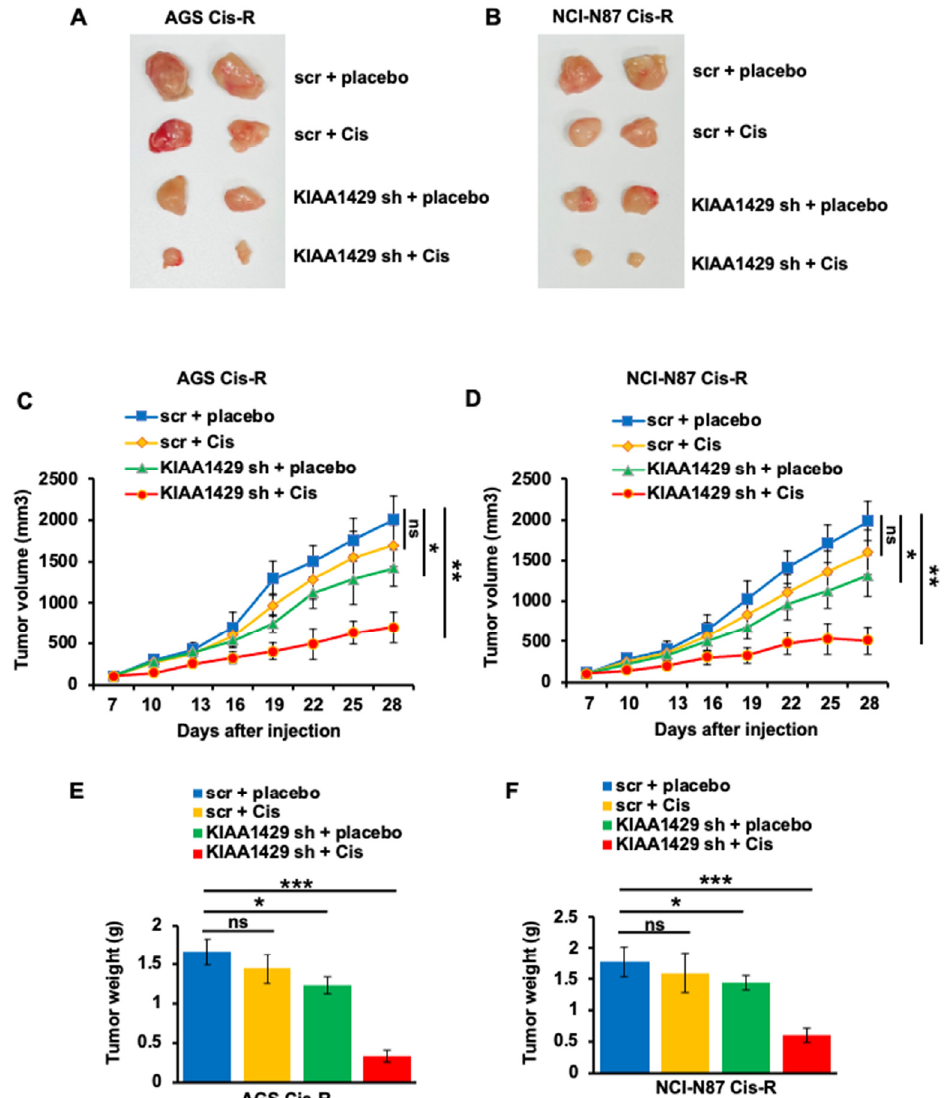
Figure 6. Effect of KIAA1429 depletion on cisplatin resistance in vivo. ( A , B ) Typical photos of tumors from each group. ( C , D ) Tumor growth curve indicated that KIAA1429 depletion significantly rescued the response of AGS Cis-R ( C ) and NCI-N87 Cis-R ( D ) cells to cisplatin. ( E , F ) The tumor weight of the subcutaneous grafts in each group at the end point after injection of AGS Cis-R ( E ) and NCI-N87 Cis-R ( F ) cells. * p < 0.05, ** p < 0.01, *** p <